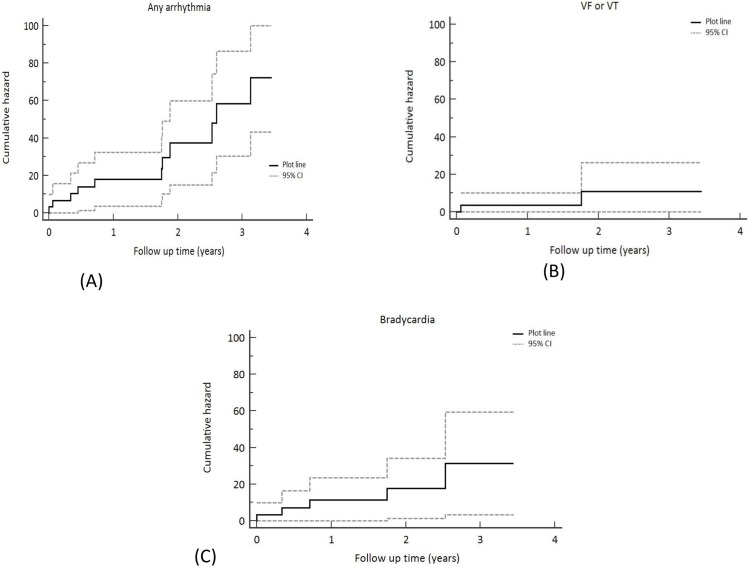
- Kaplan Meier hazard plots for (A)any arrhythmia (B)ventricular arrhythmia and (C)brady arrhythmia. (95% confidence intervals represented as dotted lines).